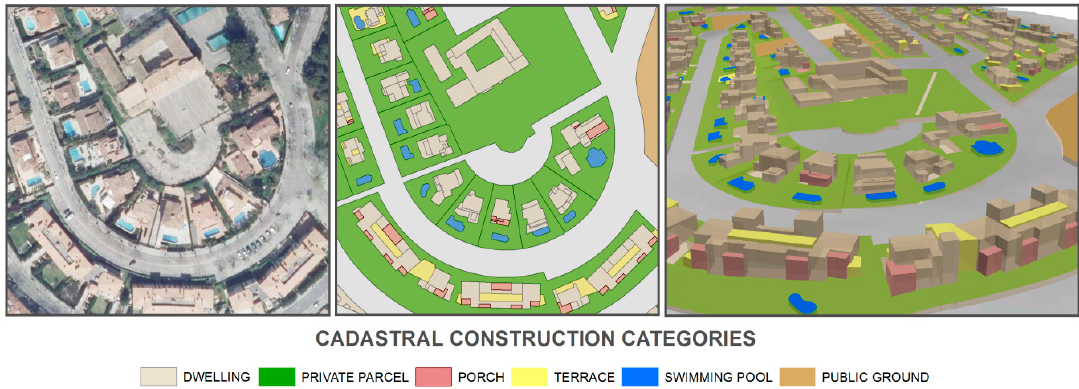
Figure 2. Orthophotography and illustration of the cadastral data used for diachronic mapping and surface measurements of swimming pools.